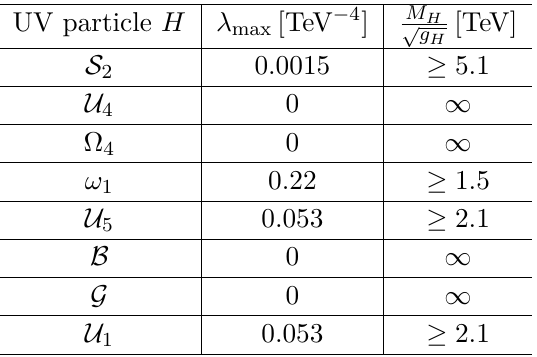
Table 8 . Lower bounds on the UV states assuming the UV model contains only the ω 1 particle, assuming M ω = 2 TeV and g ω = 1 . 1 1